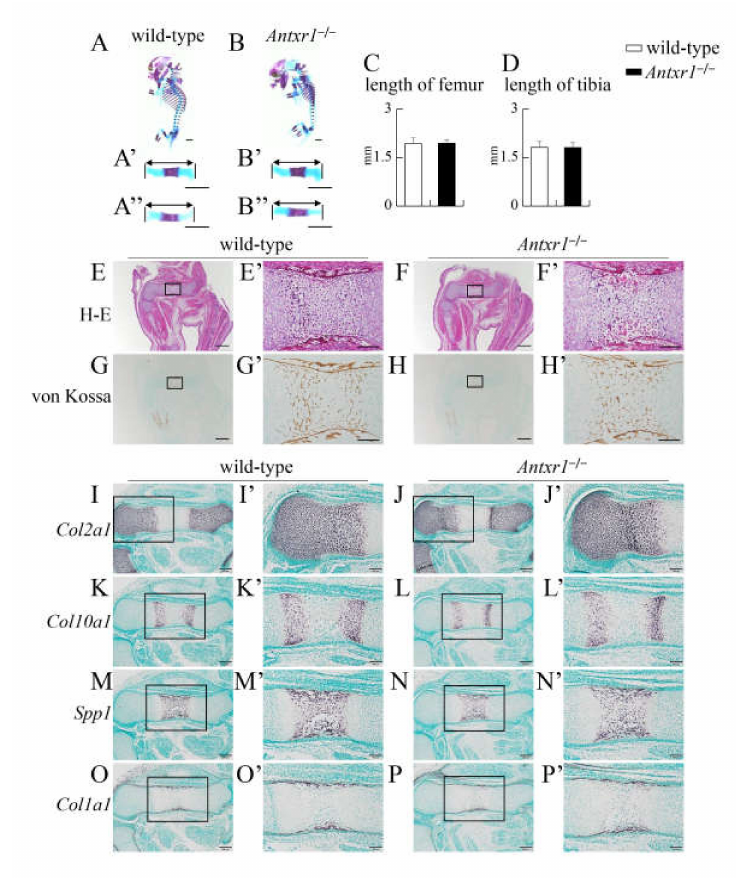
Figure 2. Skeletal system and histological analyses of wild-type and Antxr1 – / – embryos at E15.5: ( A , B ) Lateral view of the whole skeletons ( A , B ) and the enlarged views of femurs ( A’ , B’ ) and tibiae ( A” , B” ) of wild-type ( A ) and Antxr1 – / – ( B ) embryos. The lengths of femurs ( C ) and tibiae ( D ): The lengths of both sides of femurs and tibiae were measured using the skeletal preparations of 4 wild-type and 4 Antxr1 – / – embryos. ( E – H ) Histological analyses by H-E ( E , F ) and von Kossa ( G , H ) staining using femoral sections from wild-type ( E , G ) and Antxr1 – / – ( F , H ) embryos. ( I – P ) In situ hybridization using Col2a1 (I,J), Col10a1 (K,L), Spp1 (M,N), and Col1a1 (O,P) probes. The boxed regions in E – P are magnified in E’ – P’ , respectively. Scale bars: 1 mm ( A , B ), 500 µ m ( E – H ), 200 µ m ( I – P ), and 100 µ m ( E’ – P’ ). The number of embryos analyzed: H-E staining, wild-type: 9, Antxr1 – / – : 5; von Kossa staining, wild-type: 7, Antxr1 – / – : 3; in situ hybridization, wild-type: 2, Antxr1 – / – : 3. Similar results were obtained and the representative data are